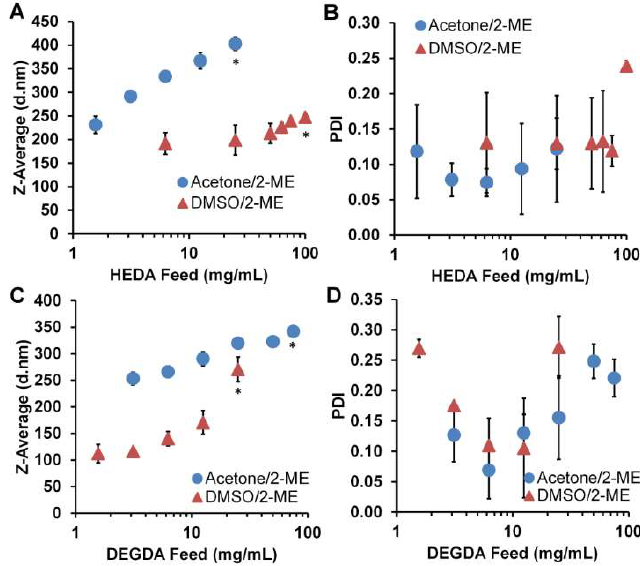
Figure 3. Comparison of oligomer feed concentration. ( A,C ) Comparison of nanoparticle z -average diameter and ( B,D ) polydispersity index of HEDA/CA and DEGDA/CA based thiolated nanoparticles, respectively, in phosphate-buffered saline/polyvinyl alcohol/ethylenediaminetetraacetic acid (PBS/PVA/EDTA). n = 3, M ± SD. * Maximum concentration before particles became unstable.